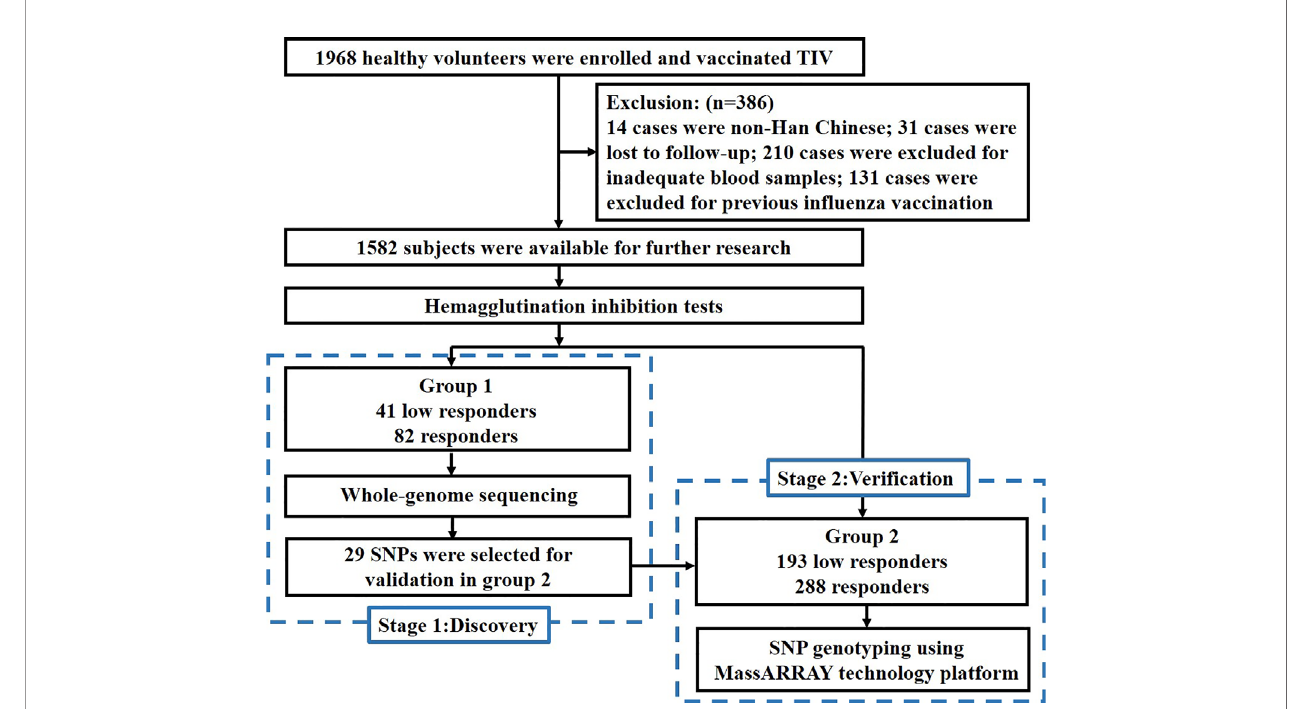
FIGURE 1 | Study fl ow